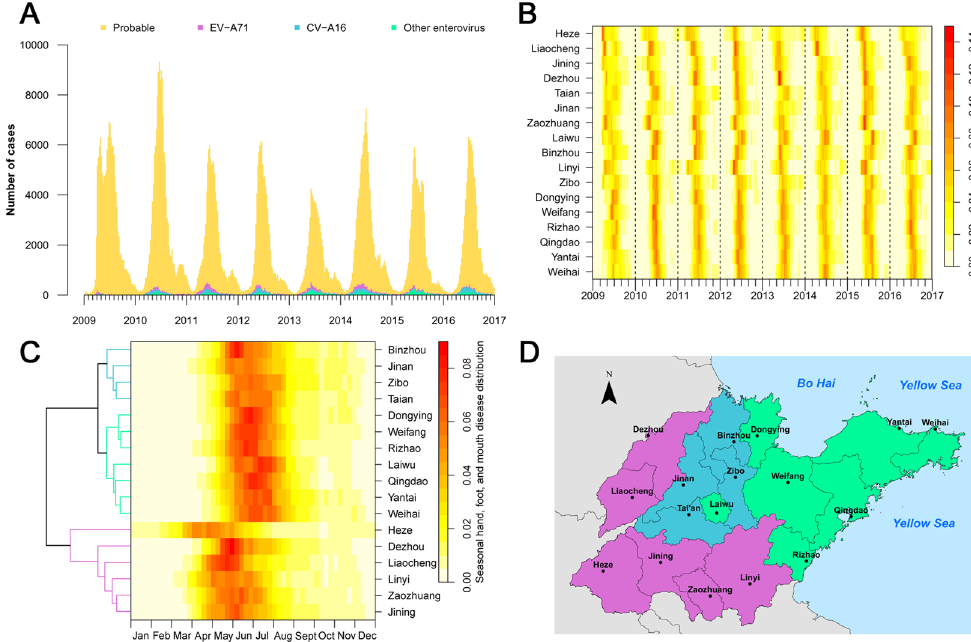
Figure 4. Heatmap of surveillance data for HFMD by city and HFMD epidemiological region, 2009–2016. ( A ) HFMD epidemic curve based on the number of weekly reported cases. ( B ) Time series of weekly reported cases of HFMD standardized by the number of annual cases. The cities were ordered by longitude from the westernmost (top) to the easternmost (bottom). ( C ) Clustering analysis of seasonal distribution of HFMD cases, plotted as the median value of proportion of cases in each week of the year from 2009 to 2016. ( D ) Classification of the epidemiological regions by clustering